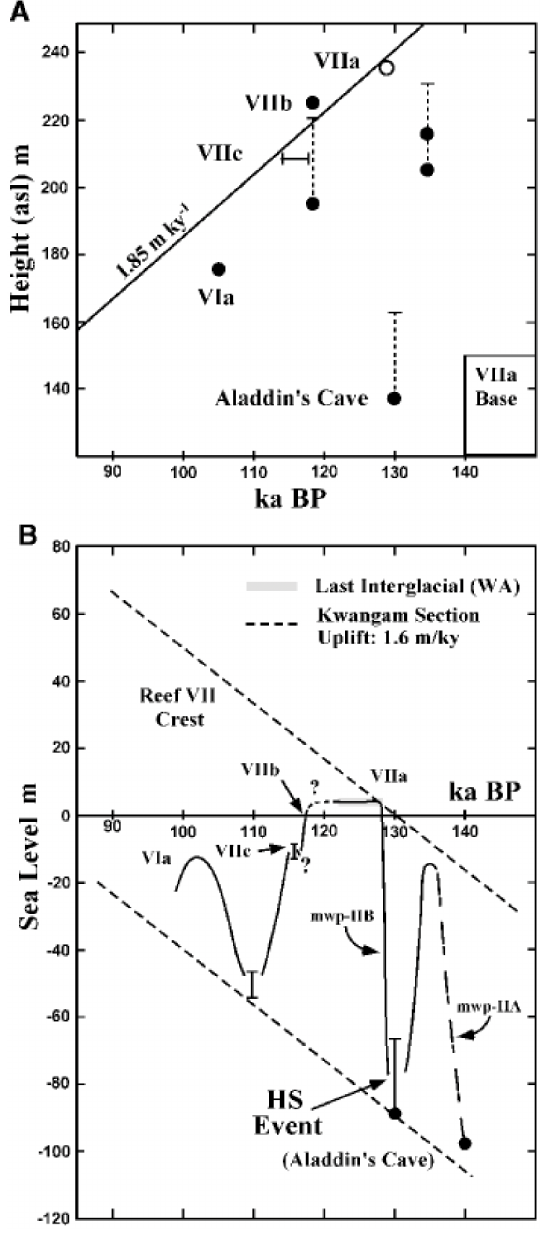
Figure 32. (a) The age–height relation for dated terraces at Kwambu that was constructed by assuming that the top of terrace VIIa at 118 to 120ka was 0 to 5m above the present sea level. The dashed vertical lines indicate the possible range of water depth (0 to 20m) in which corals grew. (b) Eustatic sea-level curve for the penultimate deglacial period and the last interglacial. The smooth sea-level curve glosses over co-seismic uplift events at Huon Penin- sula, which are discrete and metre scale and would not be dis- cernible at this scale. The diagonal dashed lines represent the uplift with time for the crest of reef VII and Aladdin’s Cave (from Esat et al.,